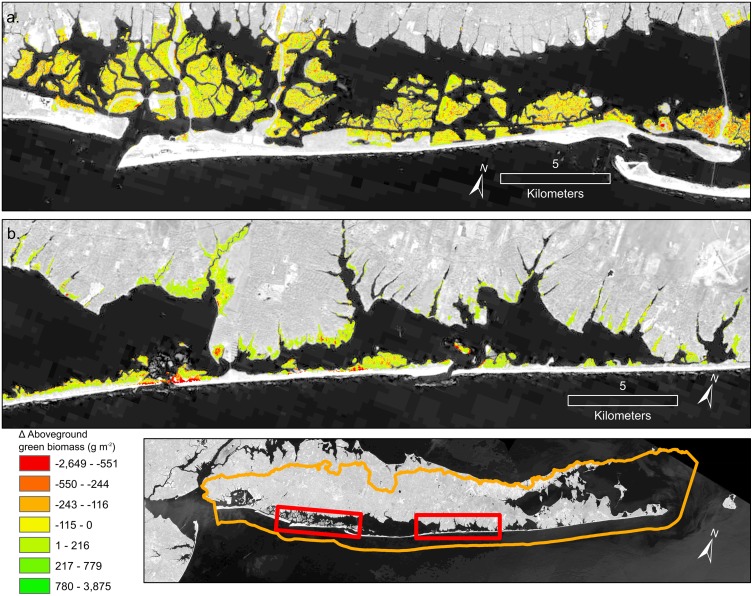
Two subsets of the Southern Long Island watershed.Change in AGB from 1999–2018: a) the back bay salt marshes of Jones Beach Island; b) the north-eastern section of Fire Island and Moriches Bay. Background imagery Landsat 8 courtesy of U.S. Geological Survey.